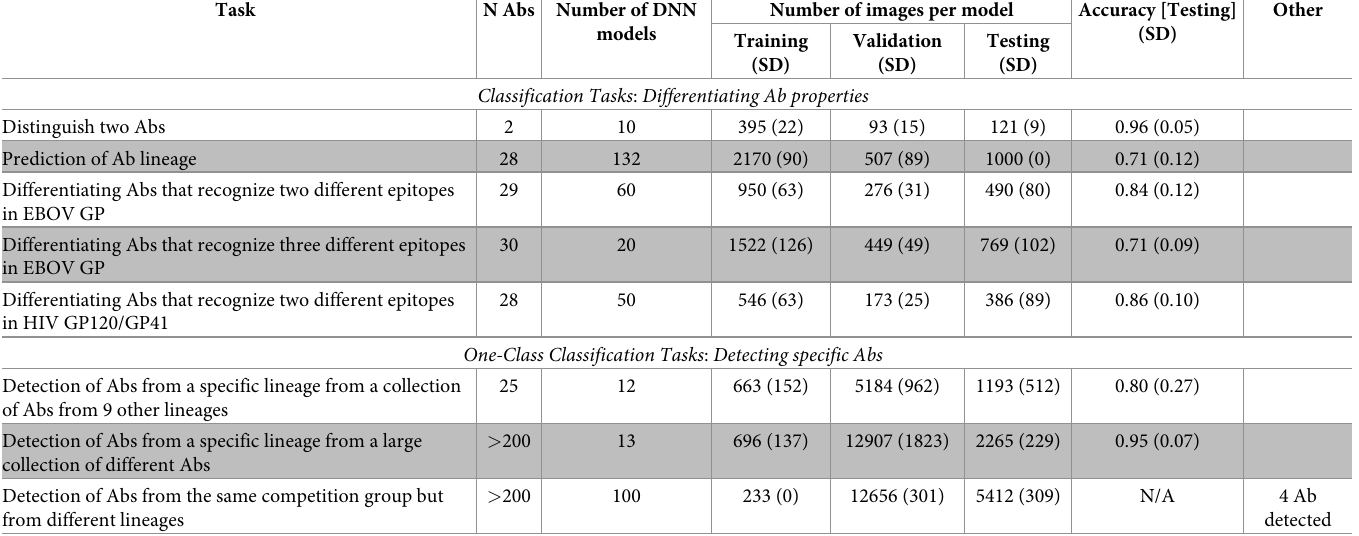
Table 1. Summary of examined Tasks, the number of Abs, DNN models, and fingerprint images used in each Task. Task N Abs Number of DNN